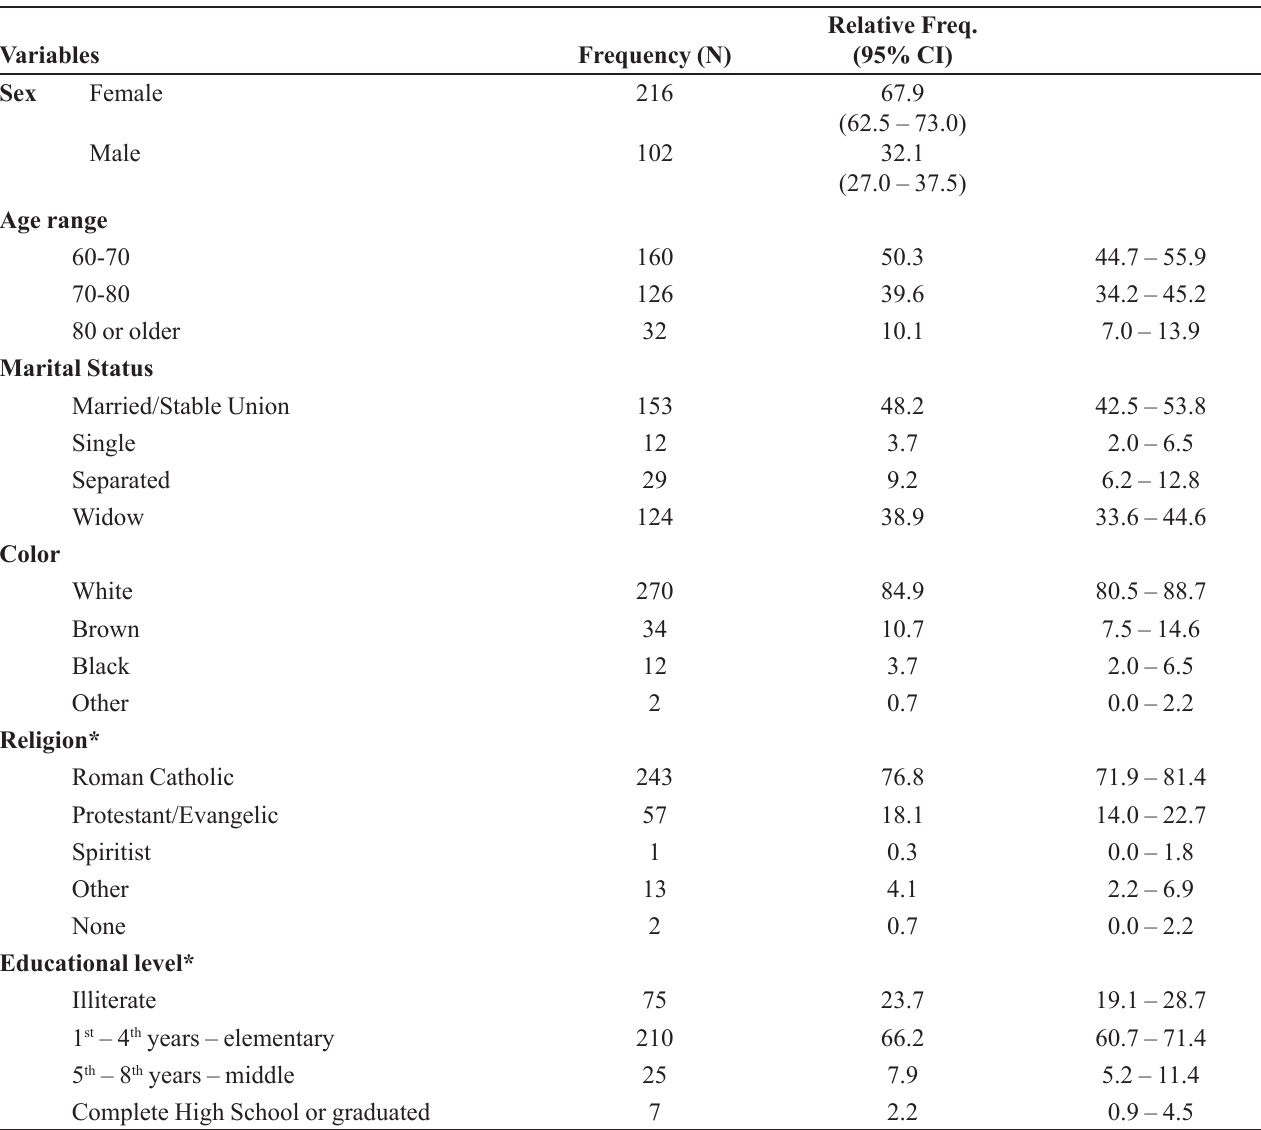
TABLE I - Socio-demographic